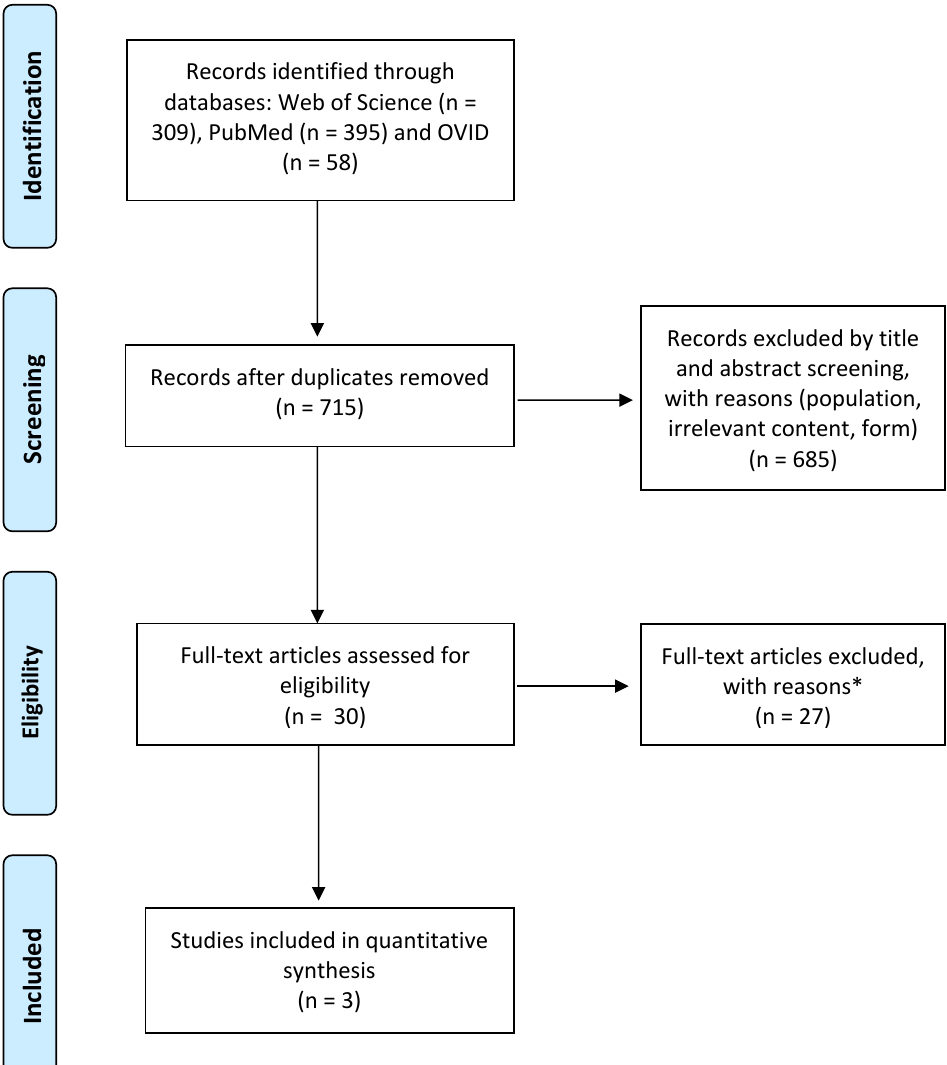
Figure 1. PRISMA flow diagram. * Reasons for exclusion included ineligible population (n = 15), ineligible intervention (n = 9), outcomes not reported (n = 3), other (irrelevant content, n = 1; ineligible language, n = 1; inadequate methodology, n = 1). Adapted from Moher et al.